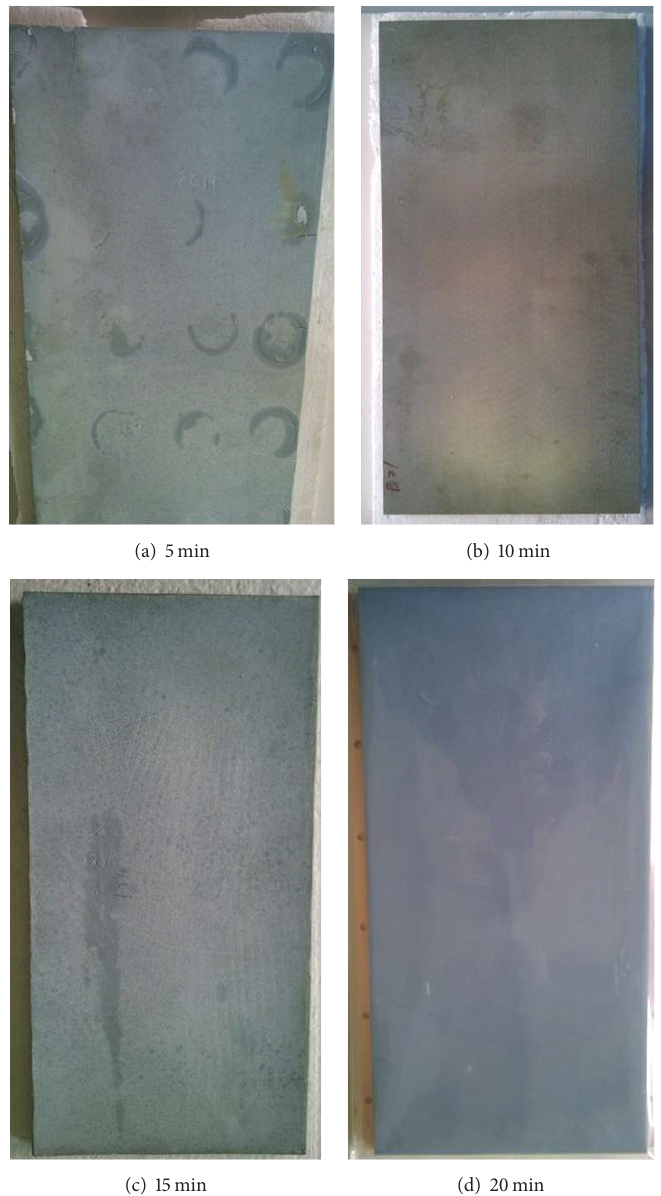
Figure 12: Photographs of AZO targets after sintering with different change rates of microwave power.